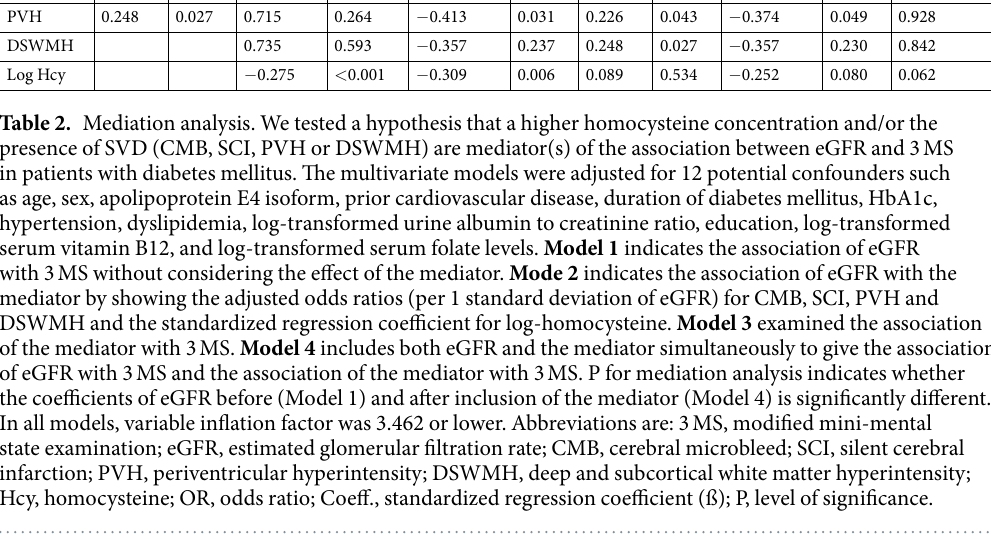
mechanisms such as disturbed protein methylation, promotion of calcium influx, and tau protein accumulation, finally resulting in apoptosis and neuronal death 24 . Furthermore, there is a study reporting an association between plasma homocysteine and amyloid beta protein levels in some conditions 33 . Some 25, 26 but not all studies 34, 35 found significant association of plasma homocysteine with cognitive deficit and dementia in elderly people. So